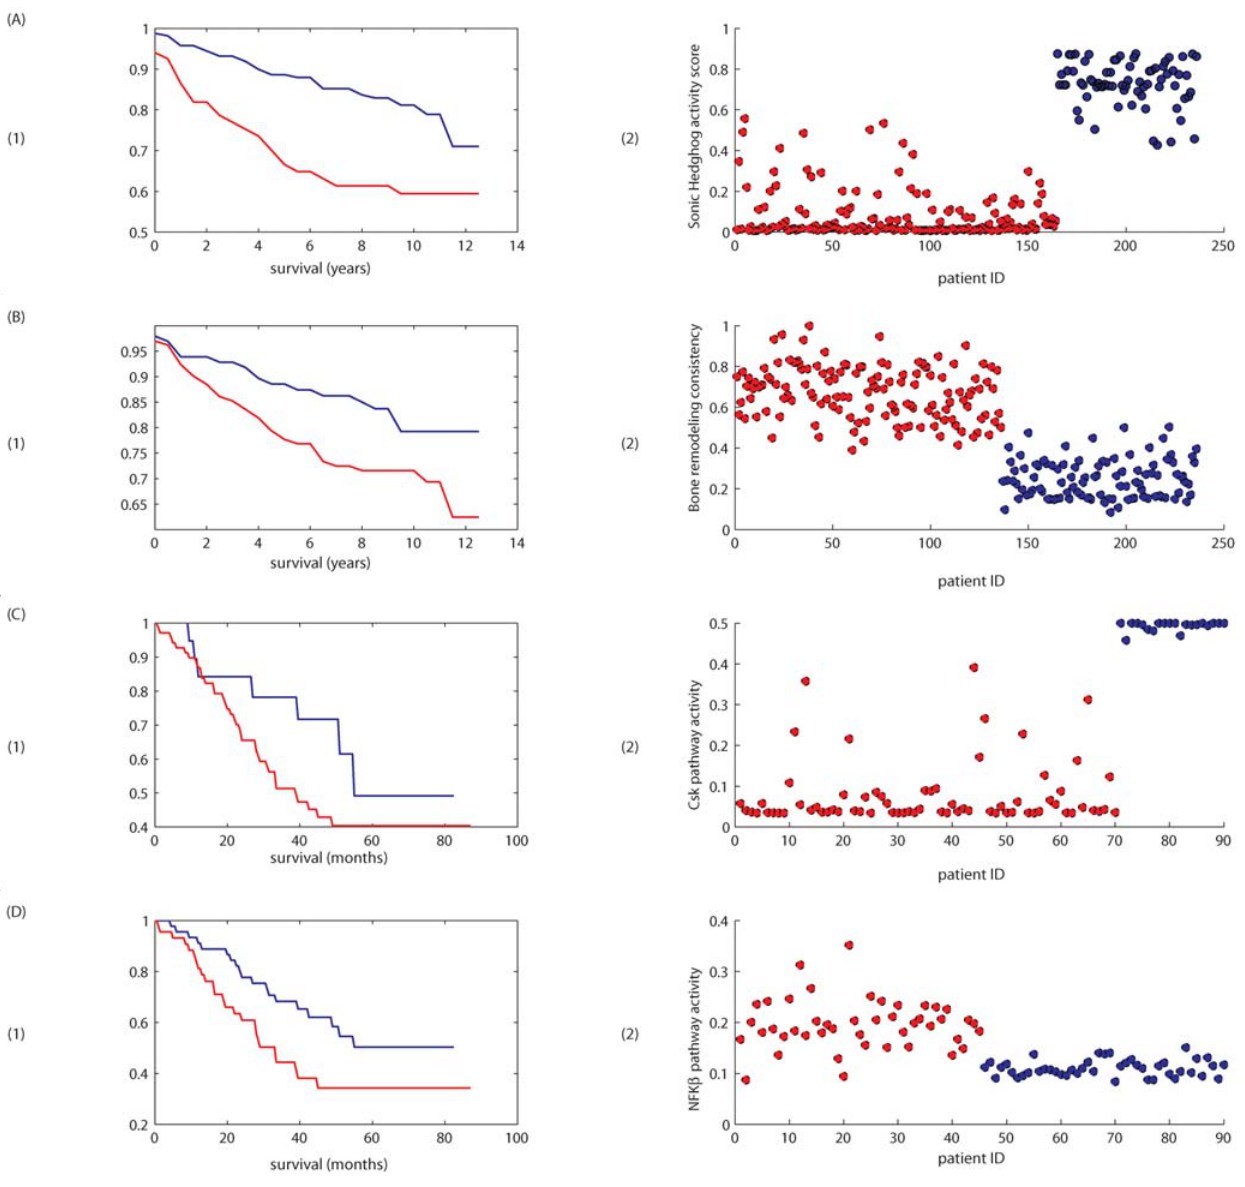
Figure 4. Examples of the stratification of survival plots and their immediate connections to pathway activity/consistency. (A) (1) Kaplan-Meier survival plot of breast cancer patients from [15], stratified according to clustering based on pathway activity. Panel (2) in (A) shows the activity score of the Sonic hedgehog pathway colored according to affiliation with either of the accordingly colored survival curves in (1); (B) The same analyses done with breast cancer patients from [15], based on the pathway Bone Remodeling (see text for pathway choice). (C) Kaplan Meier survival plots of lung cancer patient data from [17], stratified according to activity of the Csk pathway and the (D) NFK b pathway. In every panel, the (2) sub-panel shows the most influential pathway metric out of the group of stratifying pathways. This does not mean that the pathway represented is responsible for the entire separation into two groups.